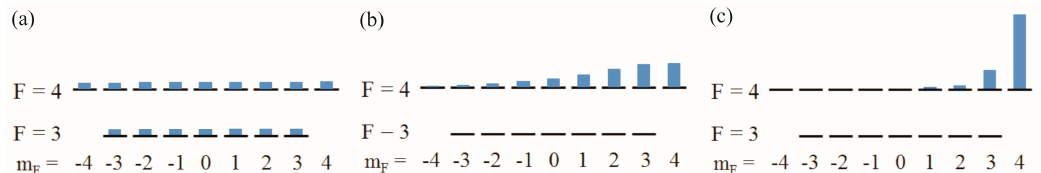
Figure 3. Populations of the Cs ground states for cells with high buffer gas pressure, calculated with the formalism developed by Scholtes et al. [35]: ( a ) in conventional M x mode operation (pumping on F = 4); ( b ) in LN M x configuration (pumping on F = 3 with about 50-fold overall pumping rate); and ( c ) in LSD-Mz configuration. (In contrast to the earlier published ones [34] these ground-state populations take into account the high buffer gas pressure and especially the redistribution of populations from the outer Zeeman levels back to the inner ones due to the 45° inclined B 0 -field with respect to the pump beam direction in Figure 3a,b.